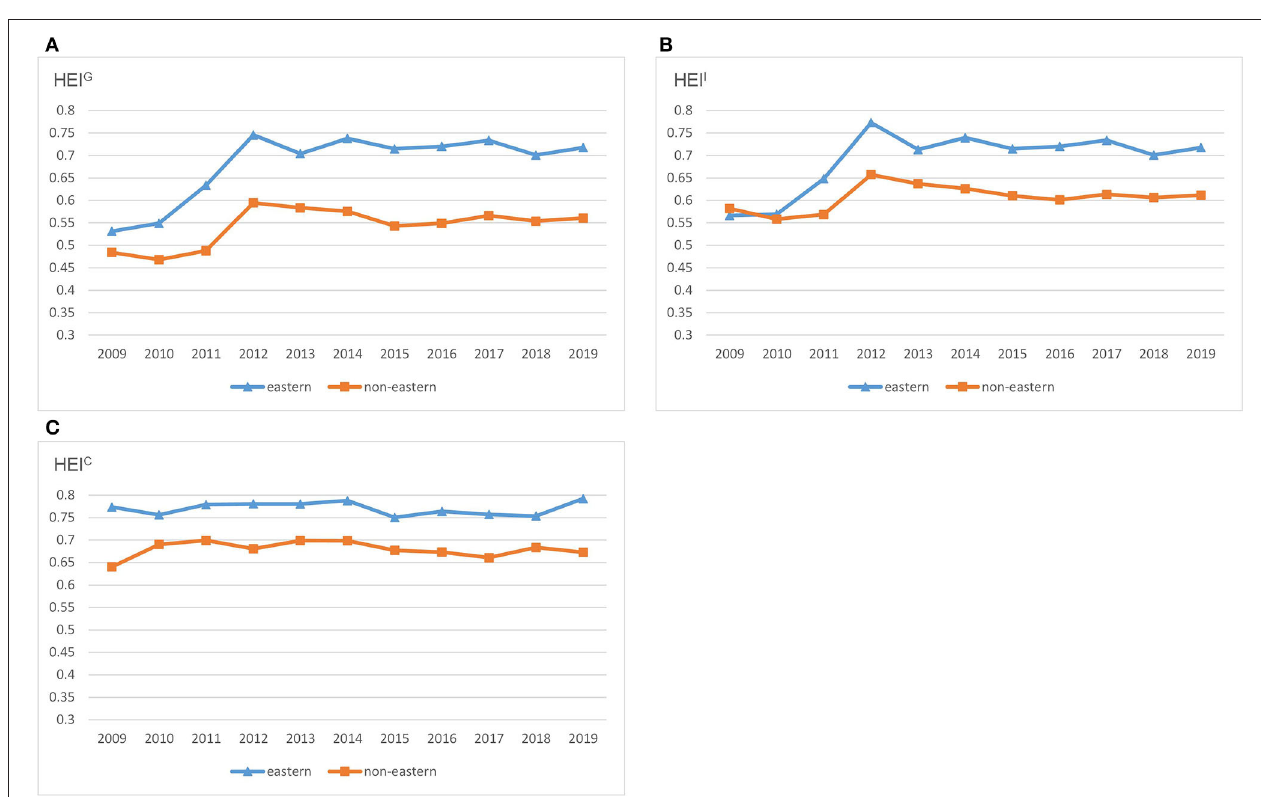
FIGURE 1 | HEI d across regions in China. (A) HEI G . (B) HEI I . (C) HEI C .